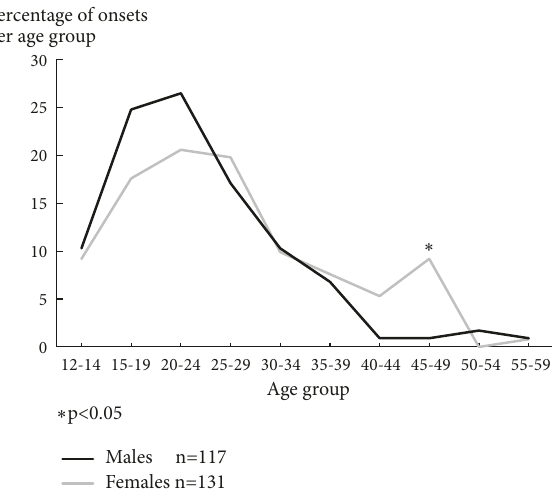
Figure 4: Distribution of age at onset of schizophrenia (first-ever sign of mental disorder) by sex; ICD 9-295, 297, 298.3, 298.4 (ABC Schizophrenia Study). Source: